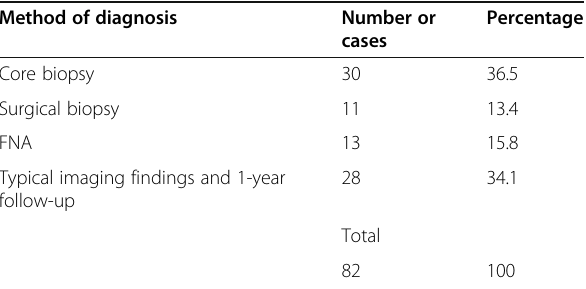
Table 2 Method of reaching final diagnosis of cases included